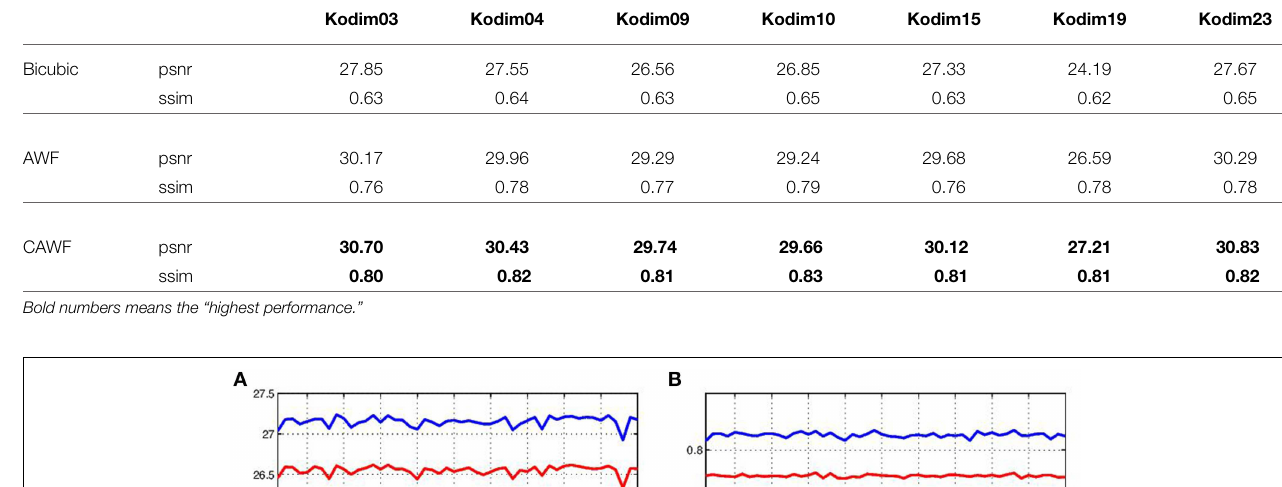
TABLE 4 | Quantitative performance of the bicubic, the AWF and the CAWF outputs for 7 Kodak images for L = 3 , P = 9 , and σ η = 10 . Method